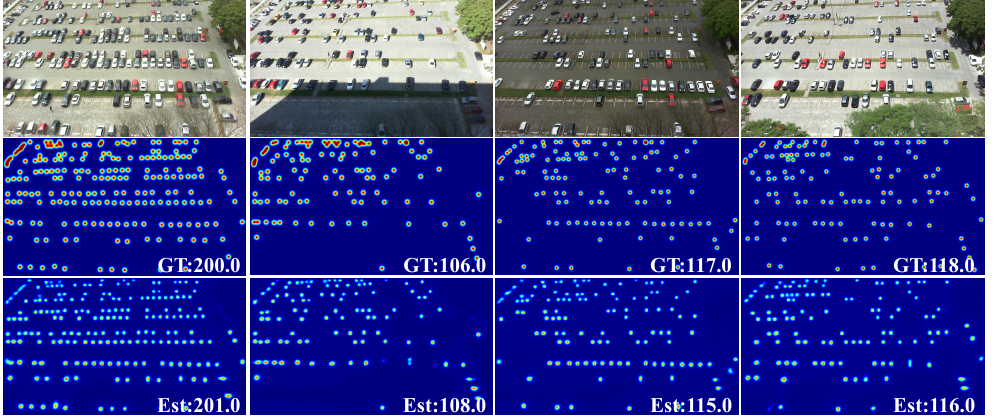
Figure 11. Subjective results on the PUCPR+